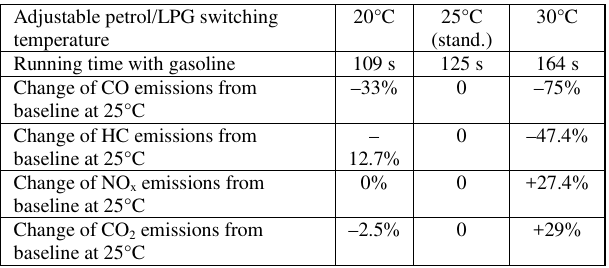
Table 3. Parameters related to the process of warming up the LPG supply system for switching from petrol to LPG – NEDC